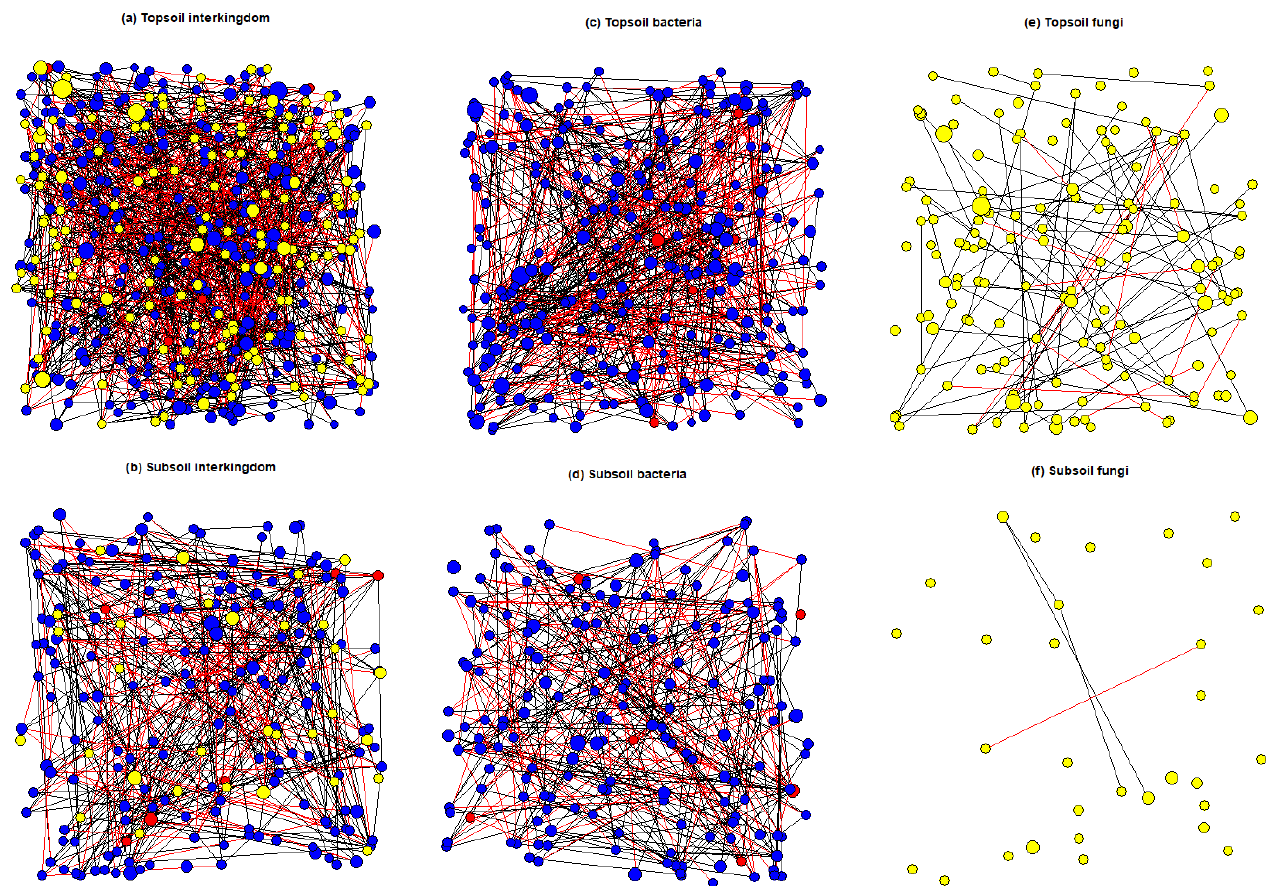
Figure 7. SPIEC-EASI networks that were constructed on core microbial genera associated with topsoil (0–30cm depth) and subsoil (30– 100cm depth) layers. Node size represents the normalised (centred log ratio) mean abundance of each genus. Blue nodes represent bacterial genera, red nodes represent archaeal genera, and yellow nodes represent fungal genera. Positive edge weights are shown by black lines connecting nodes and negative edge weights are shown by red lines connecting